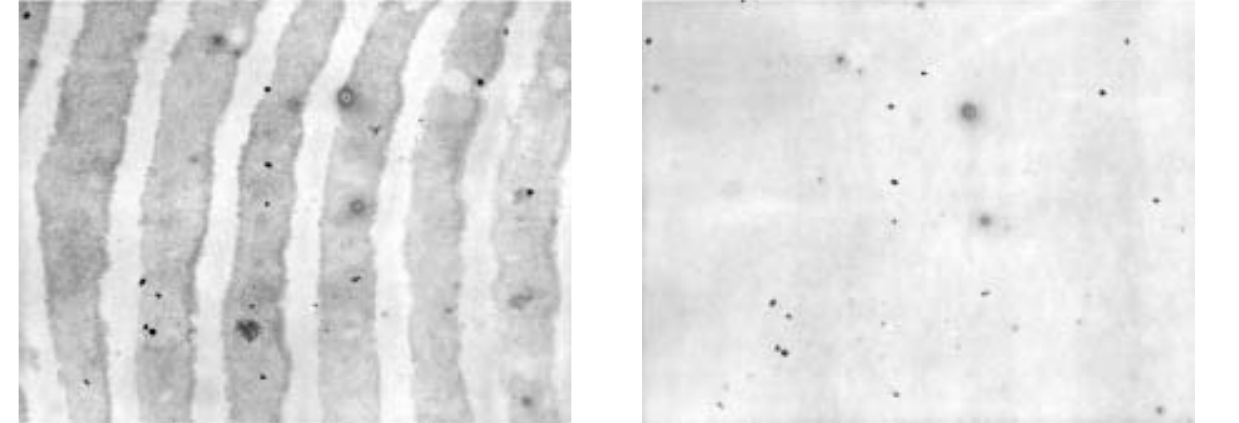
lx)Before irradiation After irradiation